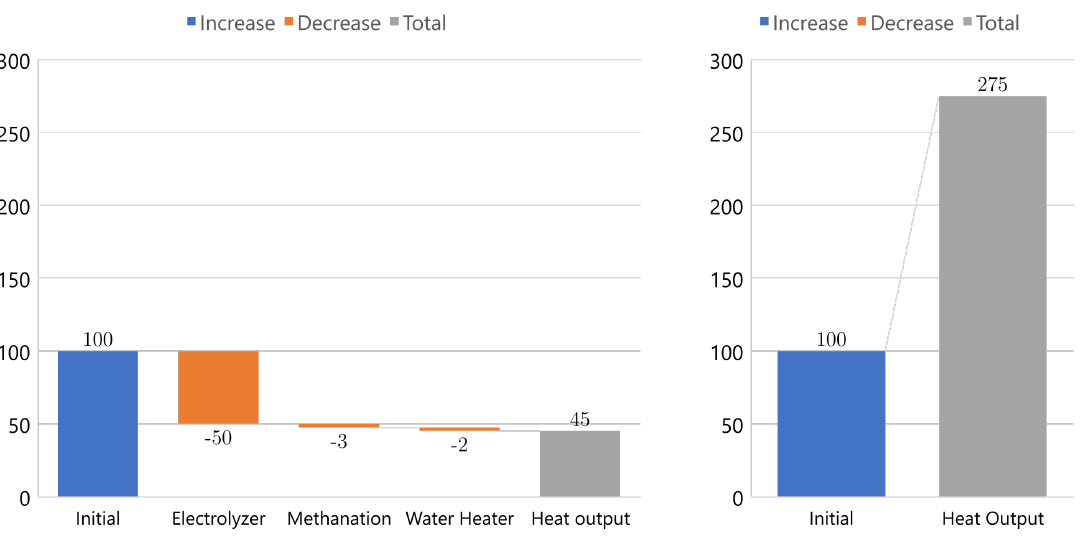
Figure 4. System efficiency comparison of electricity to heat via synthetic methane and direct use through a heat pump.